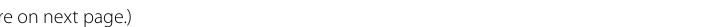
figure on next Fig. 1 NAC could ameliorate the COPD-induced pulmonary fibrosis. COPD rats were treated with PBS or NAC (n B Pulmonary function of COPD rats. C Levels of IL-6 and TNF-α in the serum of COPD rats measured by ELISA. D histological score of COPD rats detected by HE staining. E Bronchioles area, thickness bronchioles, the wall area/total bronchiole area (MA%) and the wall thickness/bronchiole diameter (MT%) of COPD rats; F Collagen volume fraction in lung tissues of COPD rats detected by Masson’s trichrome stain. G α-SMA level in lung tissues of COPD rats detected by Immunohistochemistry. Cells were treated with CSE and PBS or CSE and NAC. H Levels of IL-6 and TNF-α in cells measured by ELISA. I protein levels of Collagen I and α-SMA in cells determined by Western blot analysis. **** p < 0.0001. Data are shown as the mean standard deviation of three technical replicates. Data among multiple groups were compared by one-way ANOVA with Tukey’s post hoc ± test. Data at different time points were compared by two-way ANOVA with Bonferroni post hoc